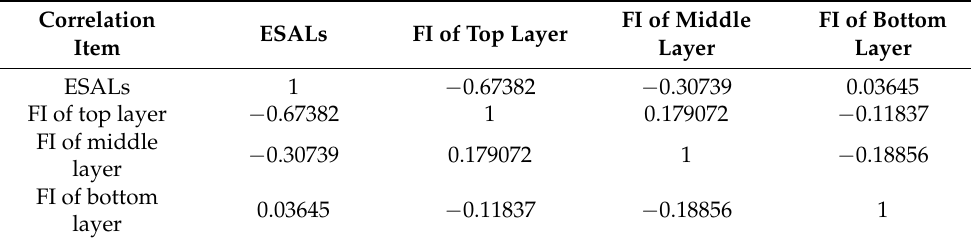
Table 5. Multivariate correlations between ESALs and FIs of the three asphalt